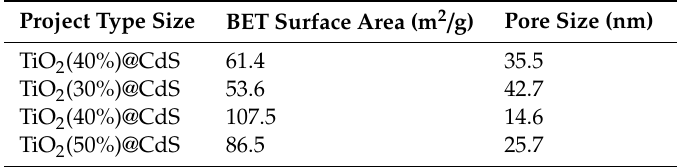
Table 1. Specific surface are and pore volume of the sample.